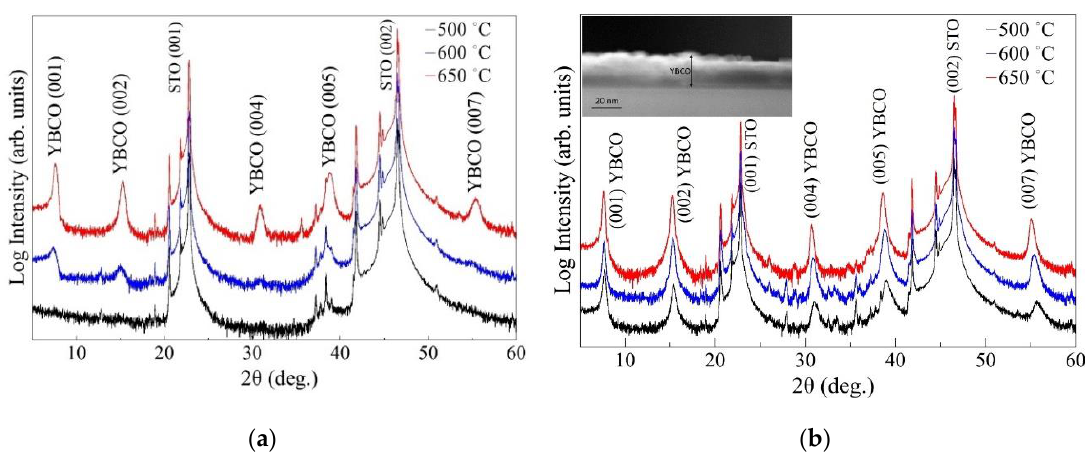
XRD 2 θ / ω patterns of the ( a ) films quenched with di ff erent holding temperatures Figure 3. XRD 2θ/ω patterns of the ( a ) films quenched with different holding temperatures at the at the pyrolysis step and ( b ) final YBCO films (after crystallization at 835 ◦ C) with di ff erent pyrolysis step and ( b ) final YBCO films (after crystallization at 835 °C) with different pyrolysis pyrolysis temperatures. temperatures. Table 1. Dependence of structural parameters of YBCO films on the pyrolysis temperature.